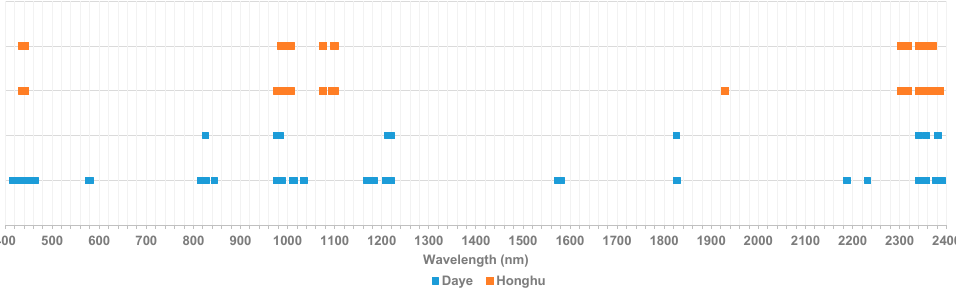
Figure 7. Plot of characteristic wavelengths based on sCARS and sCARS-SPA. The light blue square represents the characteristic wavelength selected by the sCARS-SPA, and the orange square represents the characteristic wavelength selected by the sCARS method.